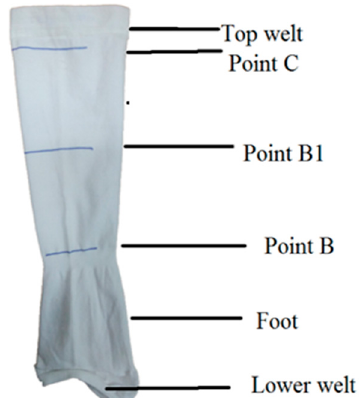
Figure 2. Graduated compression stocking with different compression levels.